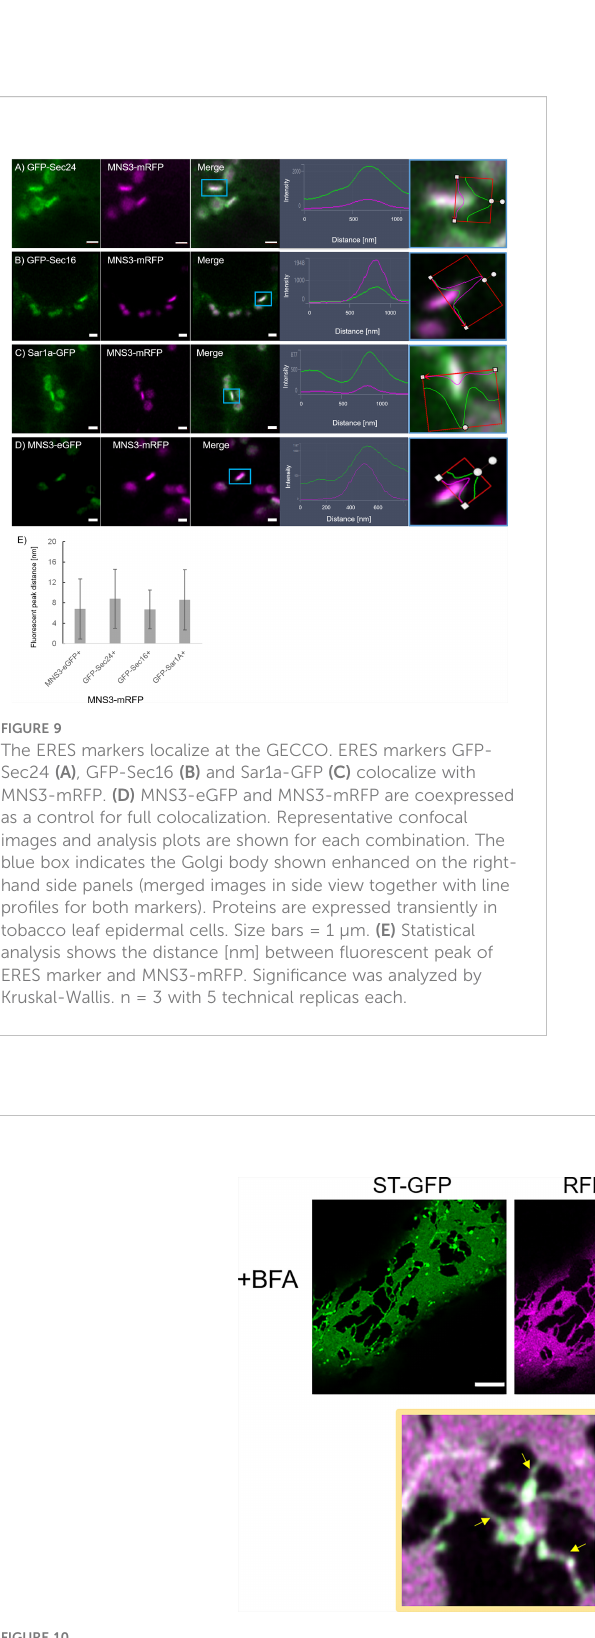
FIGURE 10 Disruption of COPI results in the redistribution of Golgi membranes into the ERGo tubules. The ER and Golgi markers RFP-HDEL (magenta) and ST-GFP (green) are coexpressed and the leaf pieces treated with BFA. Connecting tubules between ER and Golgi remnants are visible (yellow arrows). The blue and yellow boxes in the merge image indicate areas shown in higher magni fi cation below. Size bars = 5